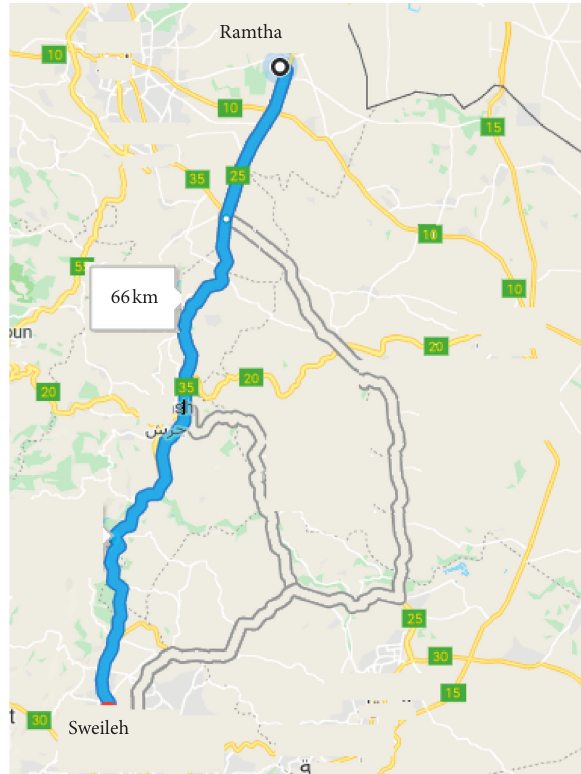
Figure 2: Driving